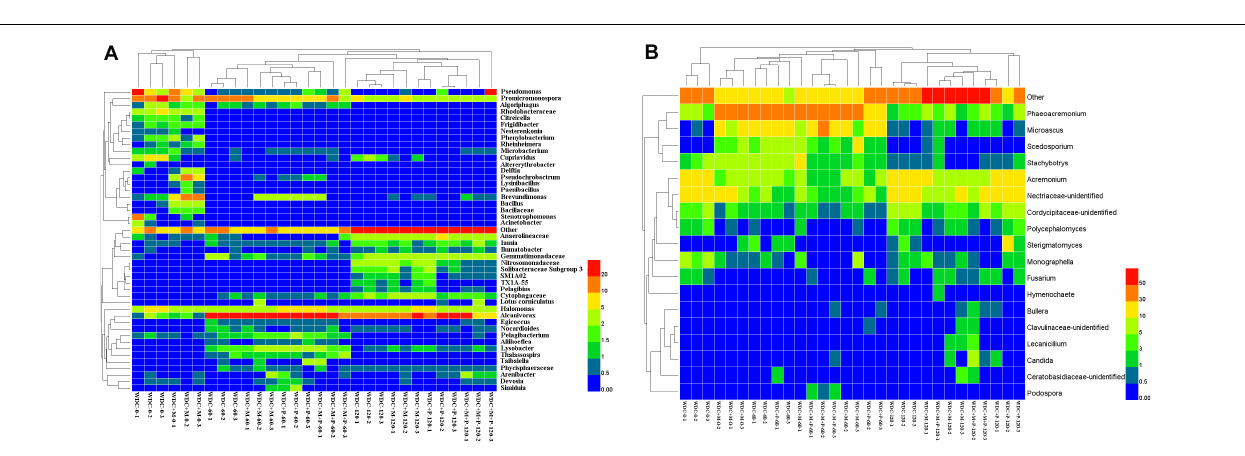
FIGURE 6 | Dominant bacterial (A) and fungal (B) taxa in waste drill cuttings (WDCs). WDCs were incubated in a greenhouse for 120 days with and without black locust ( Robinia pseudoacacia ) plant and with or without bacterial and fungal consortium inoculant. WDC, no plant and no inoculant; WDC + M, no plant and inoculant; WDC + P, plant and no inoculant; WDC + M + P, plant and